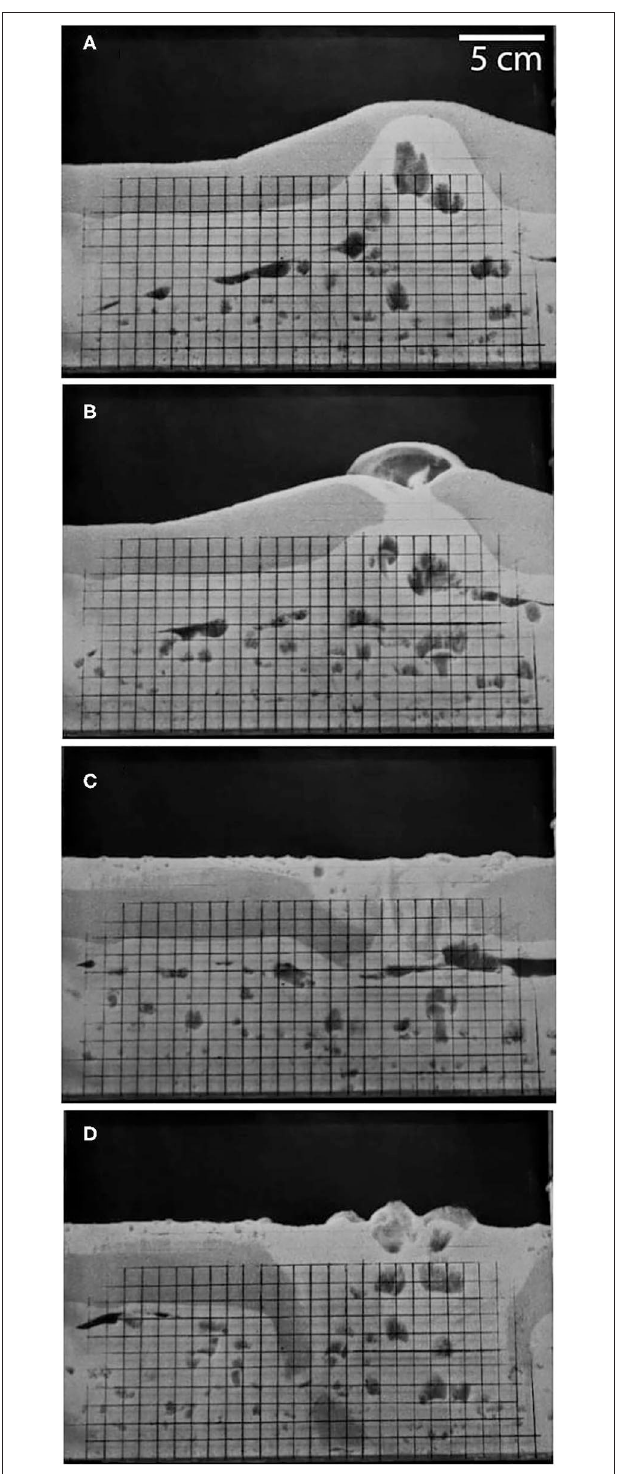
FIGURE 3 | An example of bubbling behaviour in a two-layer bed showing the progression with time from after initiation (A) to breakthrough (B) and further bubbling of fines (lighter grey) as gas continues to flow through the bed ( C then D ). r = 2.67, H c / H = 0.25, H = 12cm, d f = 125–250 µ m, d c = 400–600 µ m. The dark lines are a cm grid drawn on the front of the